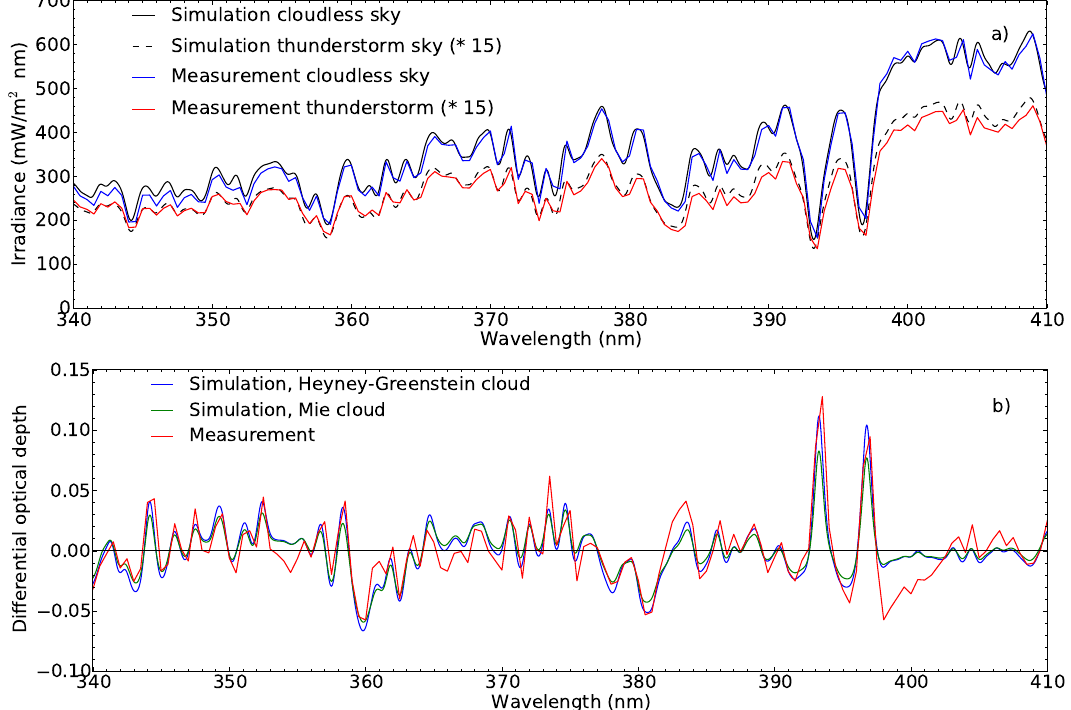
Fig. 9. (a) The measured (red and blue lines) and simulated (black line) spectra under cloudless (blue) and thunderstorm (red) situations. The measured and modelled thunderstorm spectra have been multiplied by a factor of 15. (b) The measured and simulated DOD. Simulations with both a Henyey-Greenstein phase function (blue) and an exact Mie phase function (green) are shown. The input parameters to the model simulation are described in the